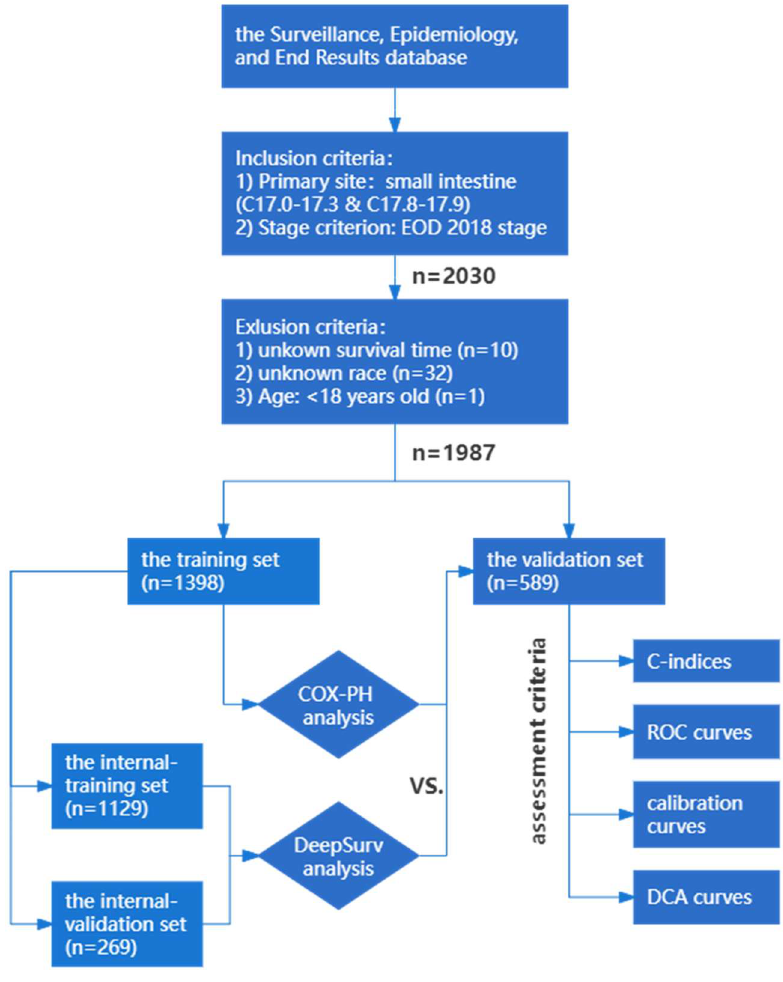
Figure 1. Flowchart of this study.